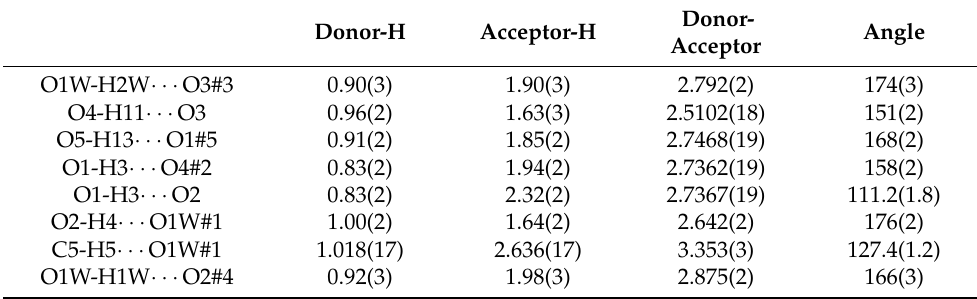
Figure 6. Repeating H-bond interactions including those with water molecule viewed down a axis. Geometrical details are in Table 2. Table 2. Hydrogen bond distances (Å) and angles ( ◦ ) for Butein crystal